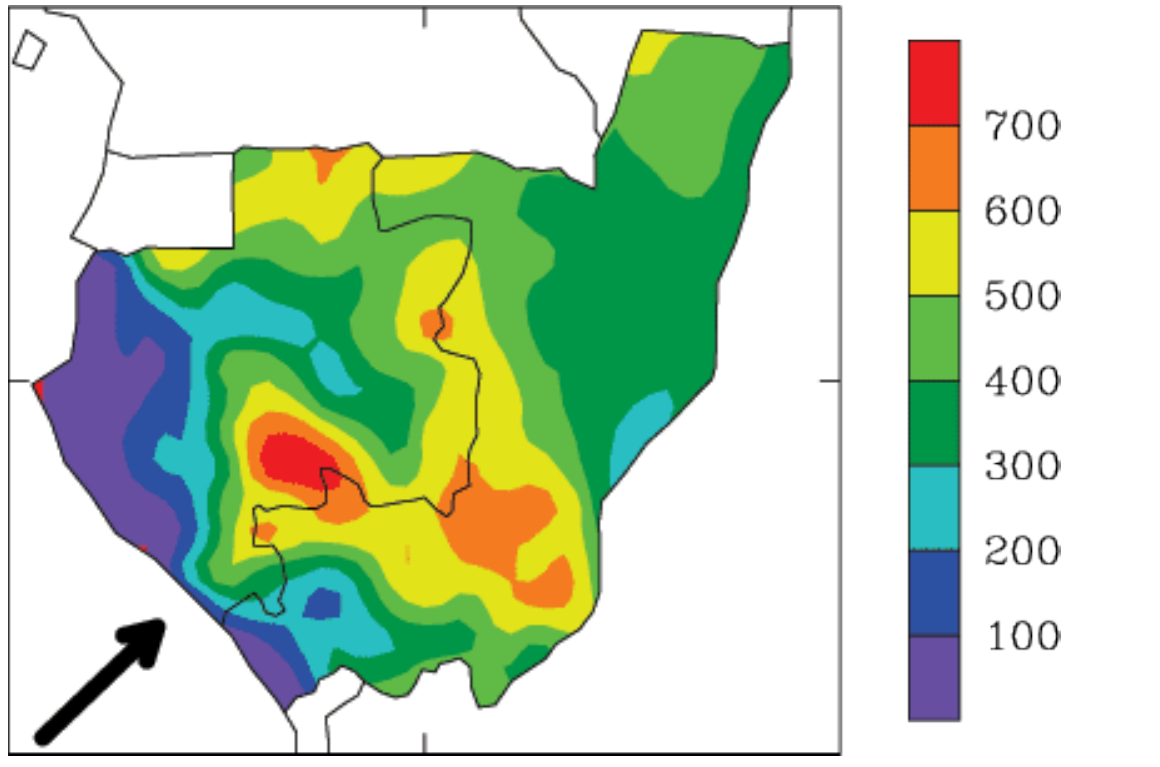
Fig. 4 . Topography (m) for Gabon and the Republic of Congo. The dark arrow shows the general direction of the path of moist airflow from the Atlantic